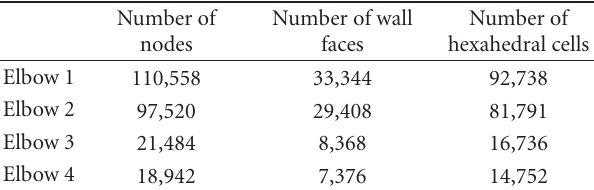
Table 2: Mesh details of all four elbows.